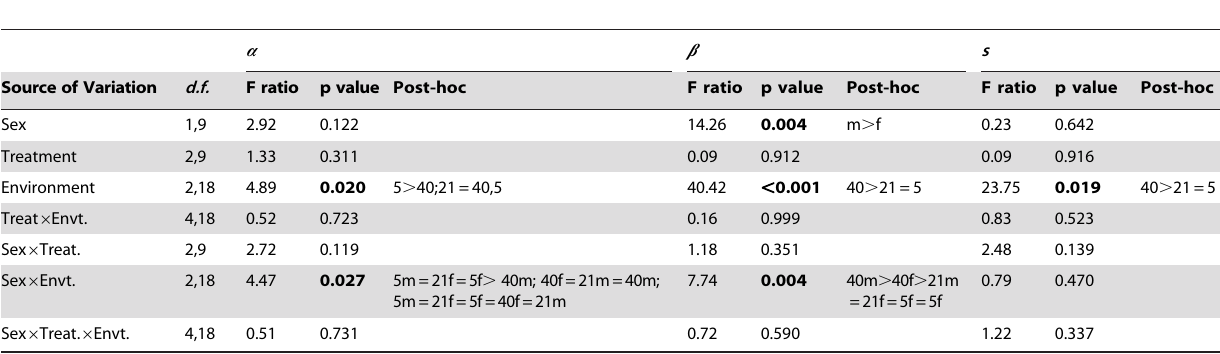
Table 2. Variation in logistic mortality parameters between sexes, treatments, and environments in a reciprocal transplant longevity assay at generation 35(30